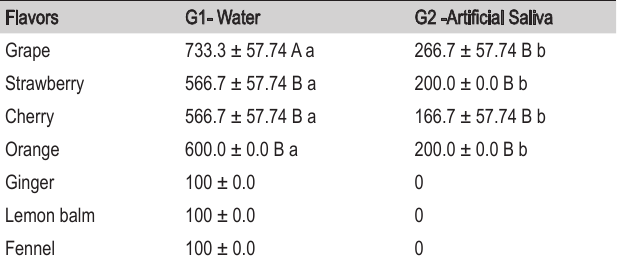
Table 2 - Mean ± standard deviation values of titratable acidity* of the different flavors of candies, after dilution in water (G1) or artificial saliva